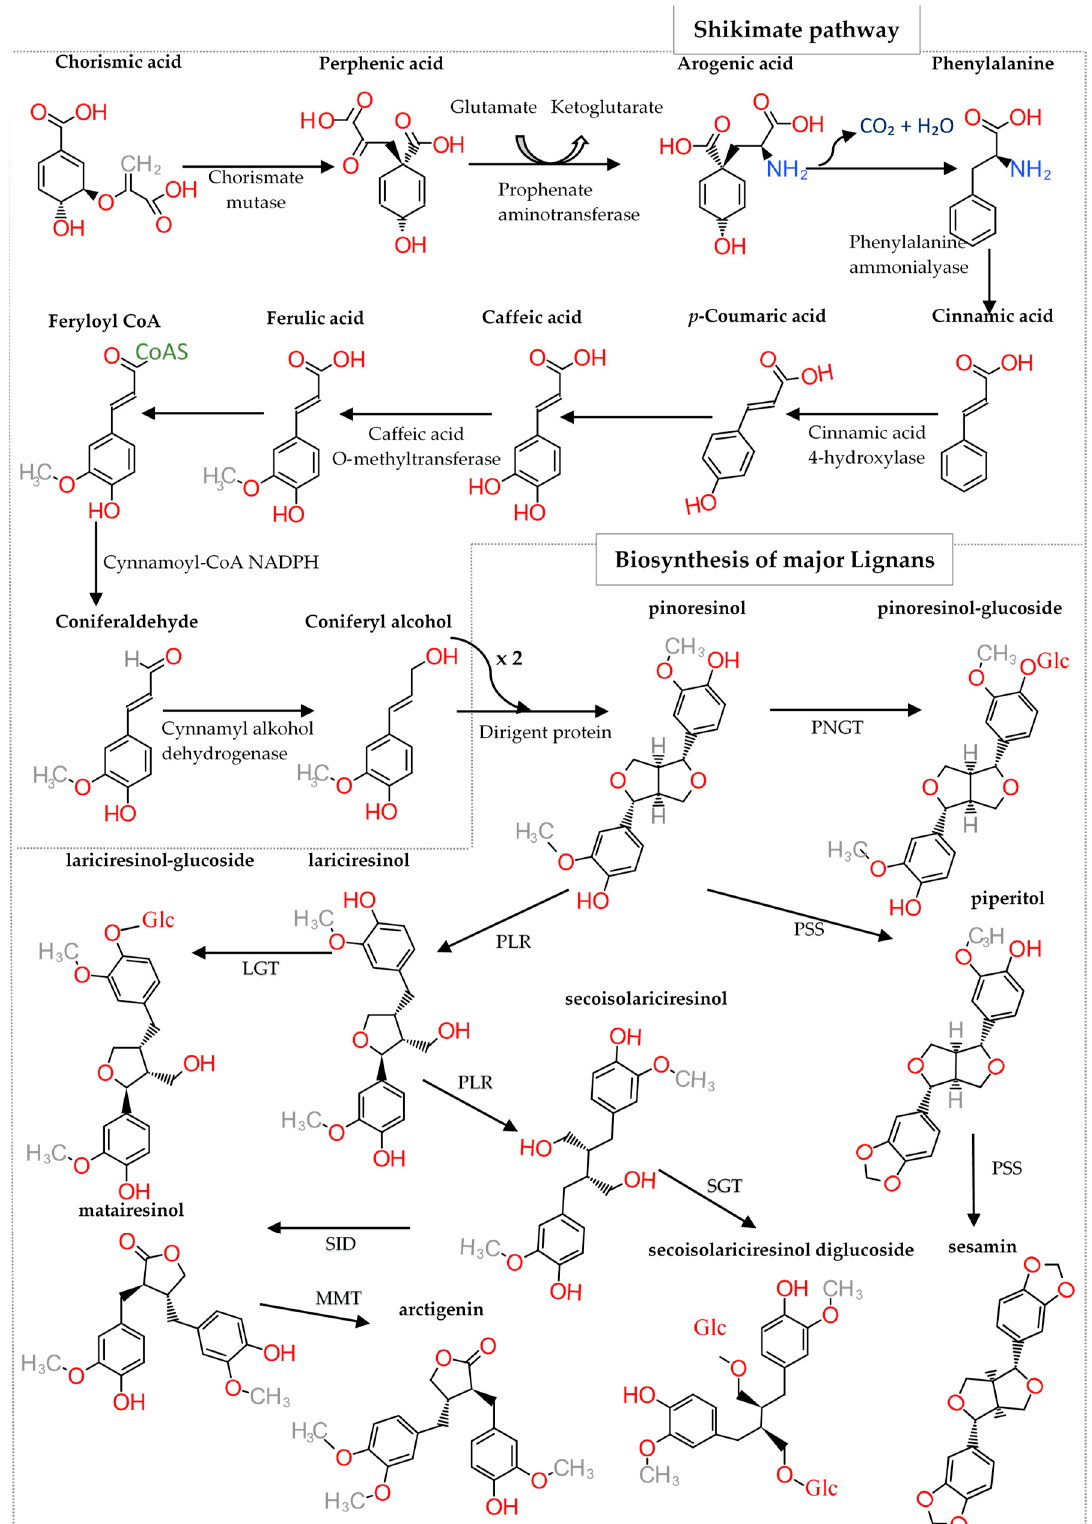
Figure 2. Biosynthetic pathway of lignans. NGT (pinoresinol glucosyltransferase), PSS (piperitol/sesamin synthase), PLR (pinoresinol/lariciresinol reductase), LGT (lariciresinol glycosyltransferase), SGT (secoisolariciresinol glycosyltransferase), SID (matairesinol O-methyltransferase), MMT (matairesinol O-methyltransferase), Glc (Glucoside).